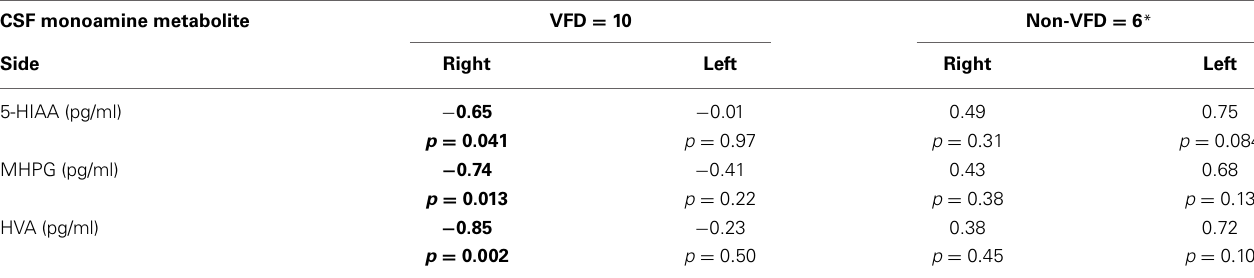
Table 1 | Correlations between hippocampal volume and CSF monoamine metabolites as a function of early life stress. CSF monoamine metabolite